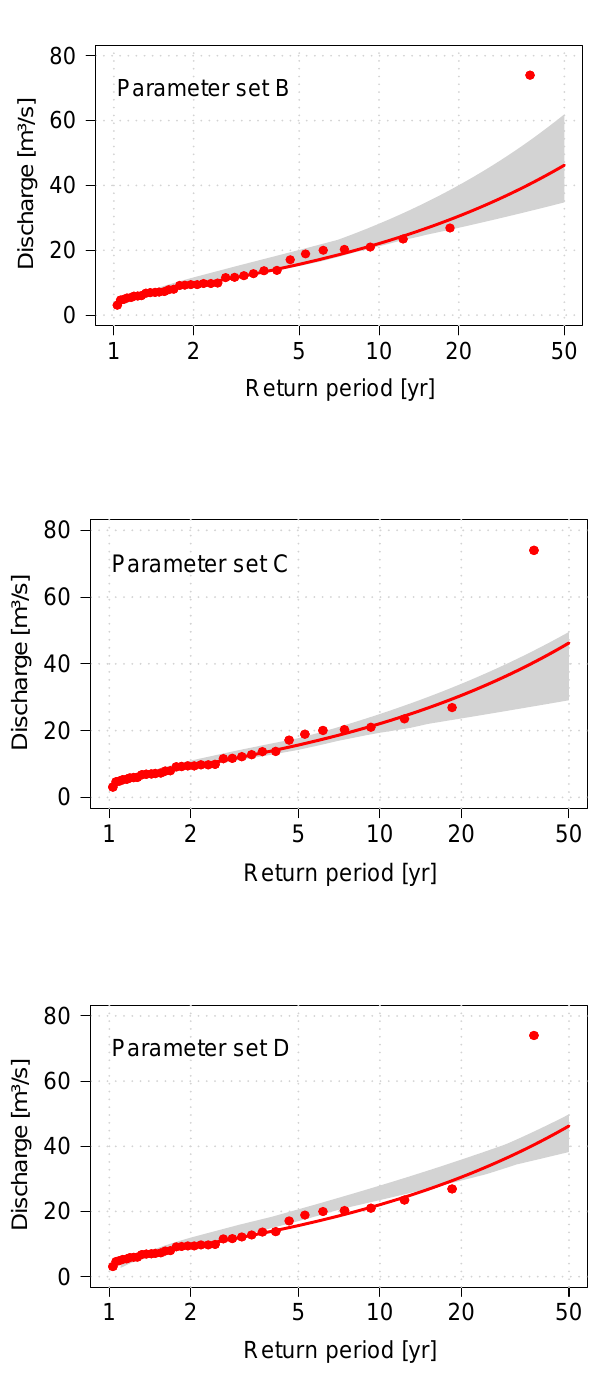
Figure 10 . Range of simulated design flows based on 20 model runs using 35 years of disaggregated precipitation data representing the 90%-confidence interval against observed peak flows for the Silberhütte catchment for different parameter sets